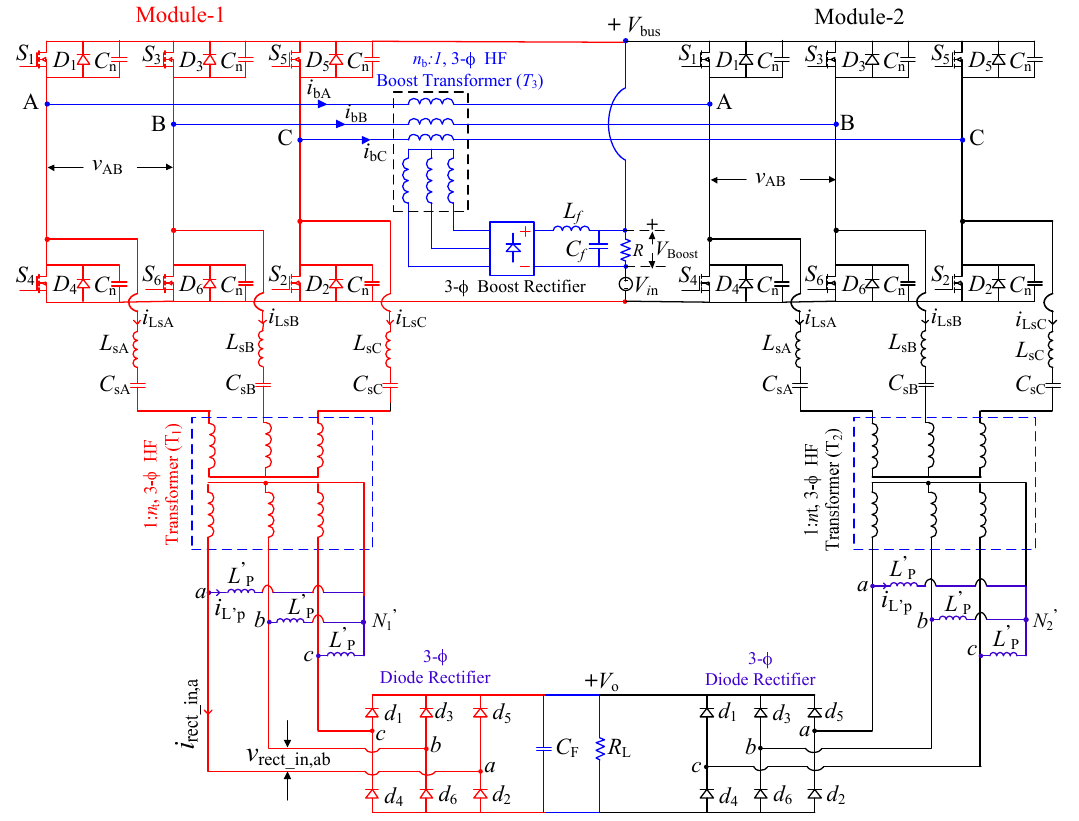
Figure 3. Proposed DC–DC LCL-type series resonant converter [24,25].